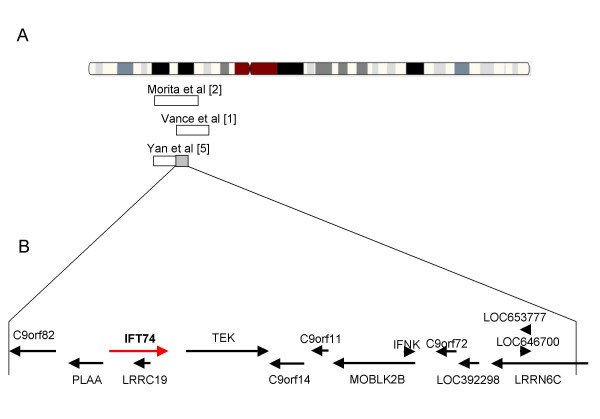
Ideogram of the Chromosome 9p ALS-FTD locus. (A) ideogram of chromosome 9 showing the linked areas defined by Morita et al, Vance et al and Yan et al in 2006. The shared region flanked by D9S1678 and D9S2154 is shaded in grey. (B) Schematic representation of the known genes and predicted transcripts in the area shared by the Dutch, Scandinavian and North American families. In red, IFT74 where sequence variants associated with ALS-FTD, ALS and FTD were identified.